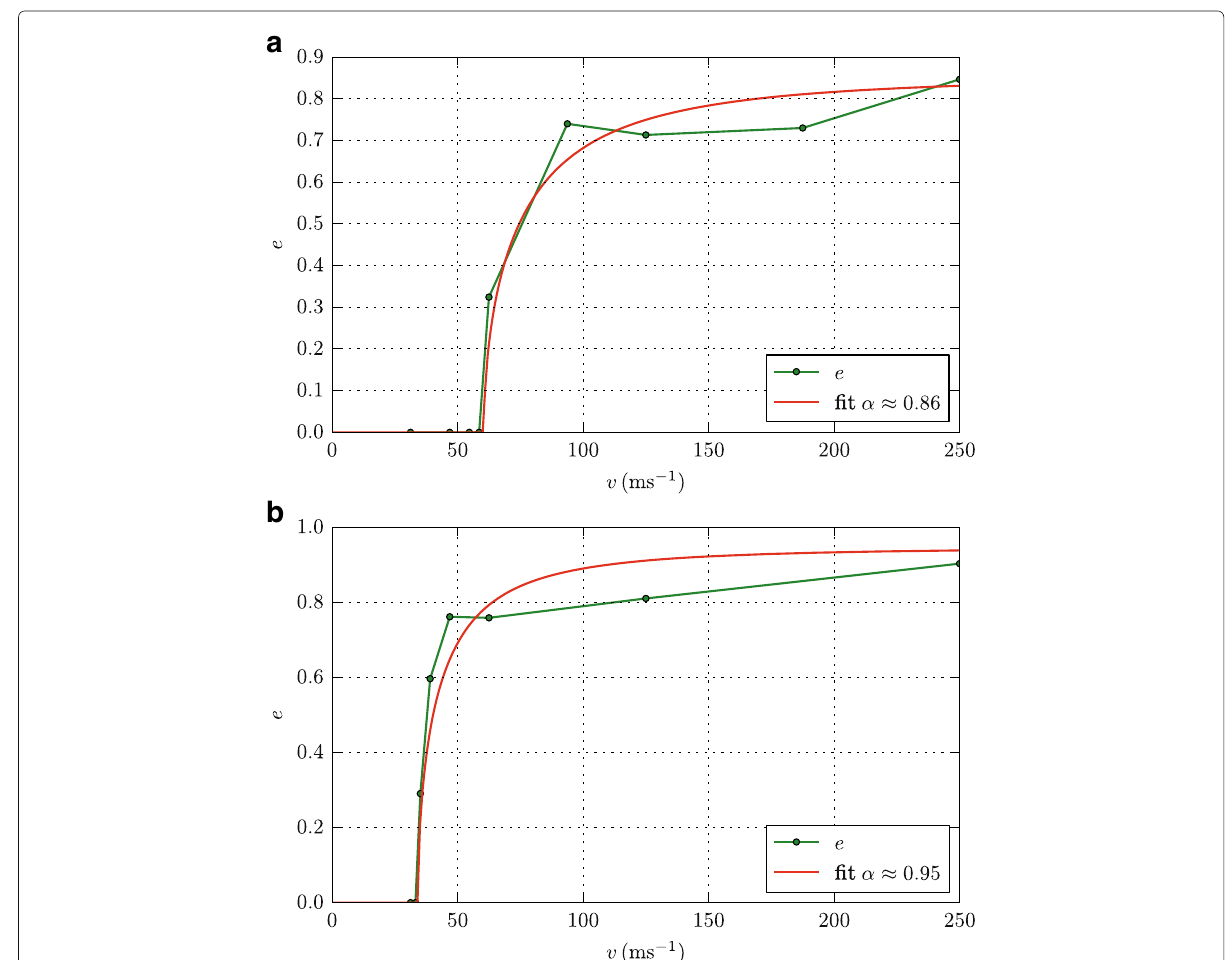
Fig. 5 Coefficient of restitution. Dependence of the coefficient of restitution, e , on collision velocity, v , for a strongly ( γ = 2.32 J/m 2 ) ( a ) and a weakly ( γ = 0.89 J/m 2 ) ( b ) adhesive surface. The bulk modulus is identical in both cases, B = 940.8. Symbols denote simulation results, while the curve is a fit to the JKR prediction, Eq. (6), with α = 0.86 ( a ) and 0.95 ( b